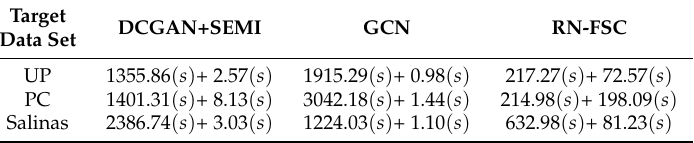
Table 13. Execution times on three target data sets (5 samples per class are used as labeled